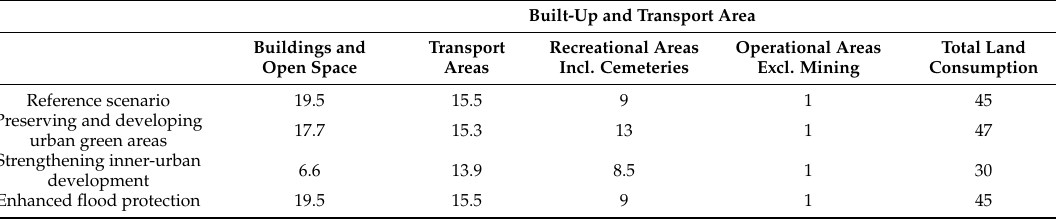
Table 4. Daily land consumption of built-up and transport area in Germany during the time period 2026 until 2030 in